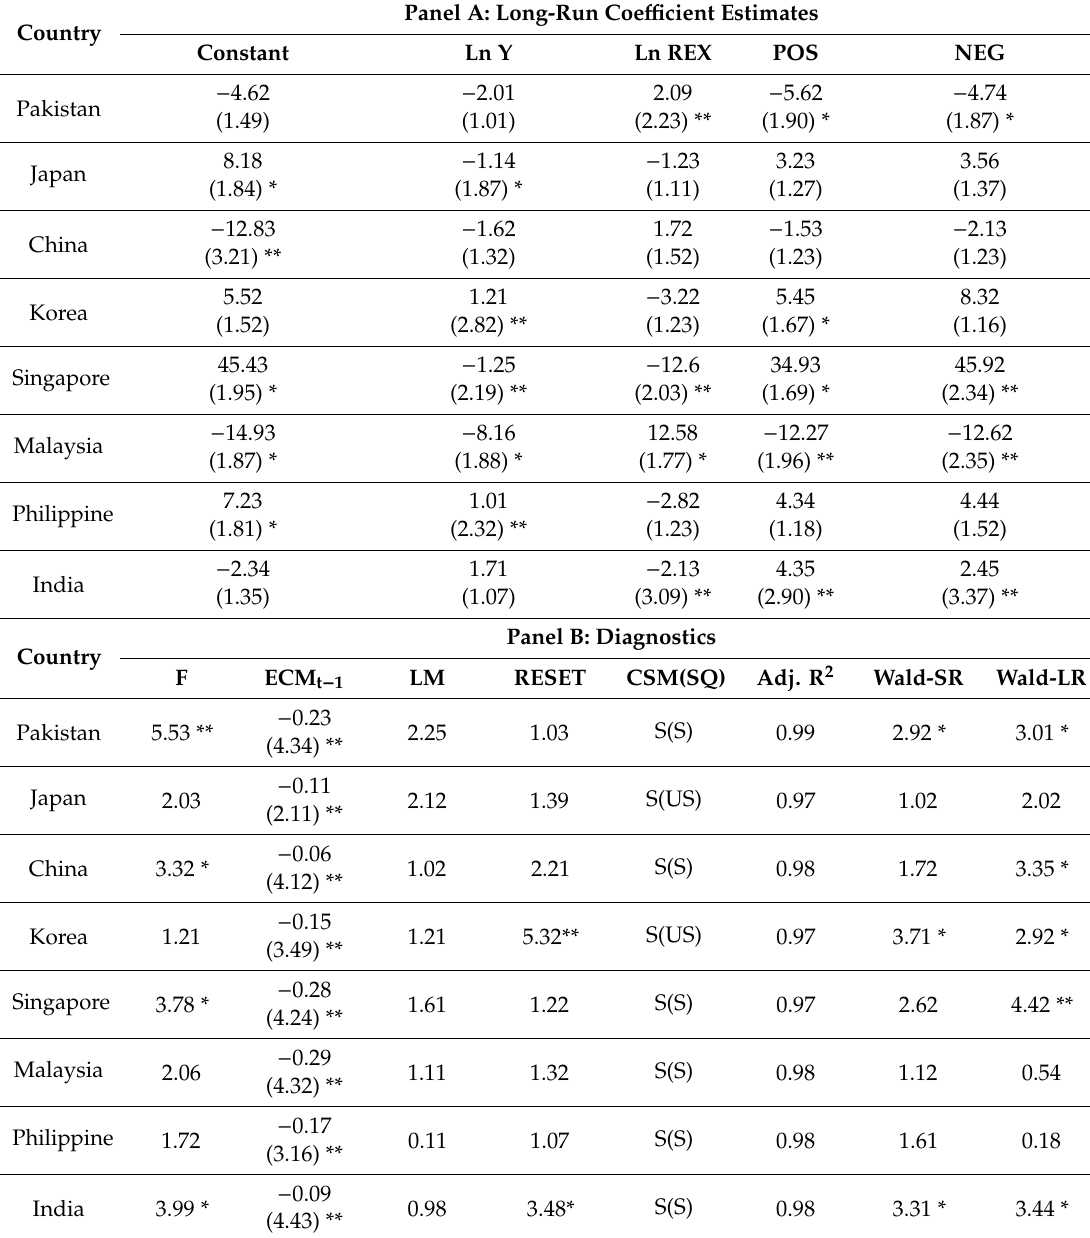
Table 8. Long-Run Coe ffi cient Estimates and Diagnostics of the Non-Linear Import Demand Model